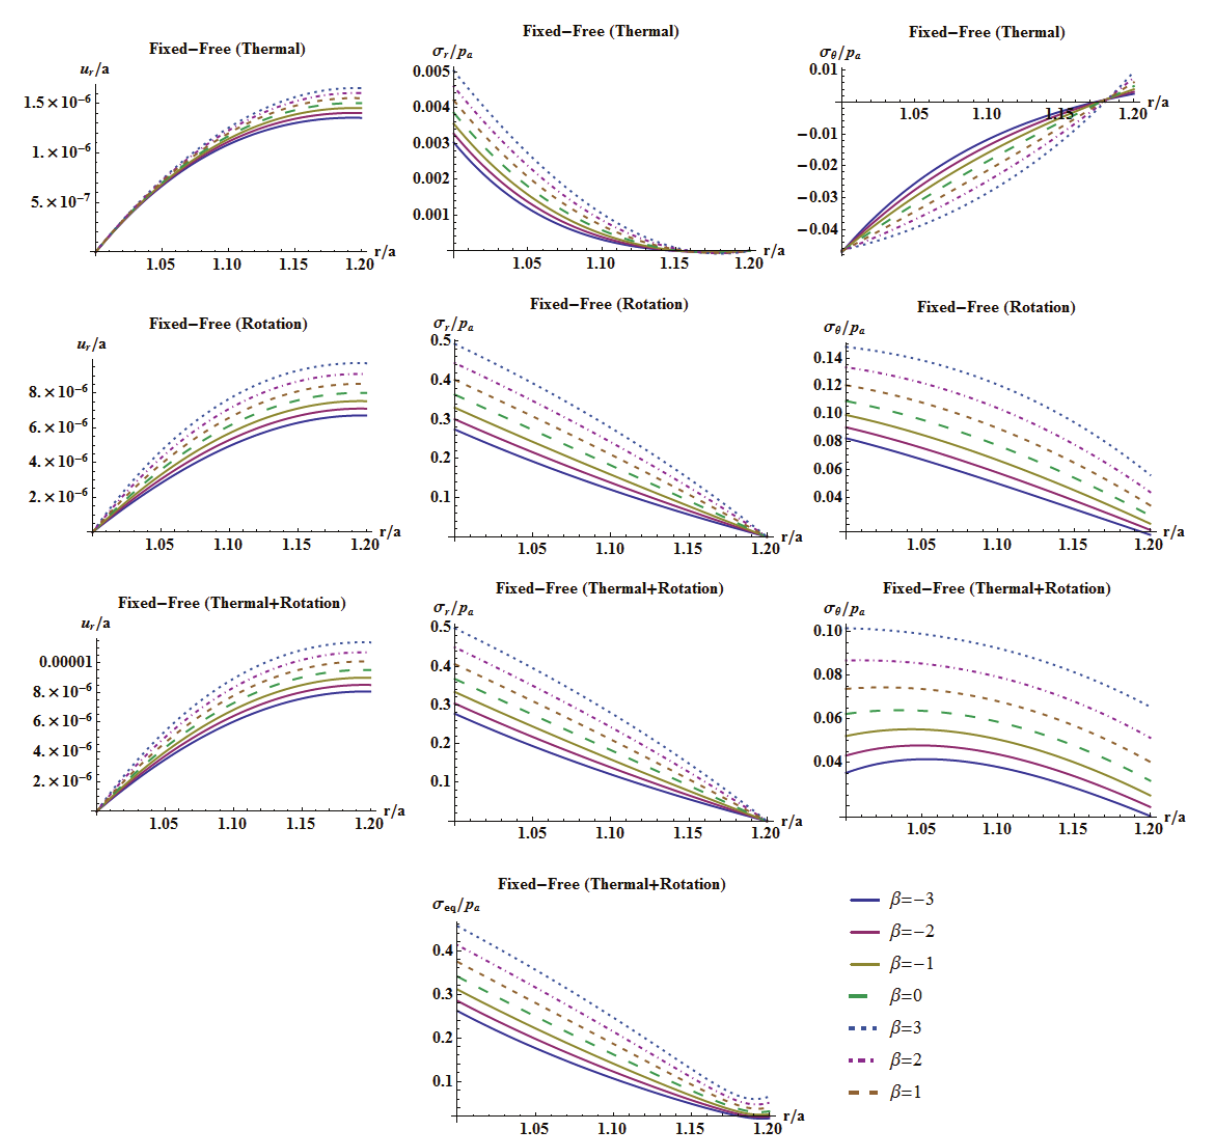
Figure 2. Variation of the dimensionless elastic fields with the inhomogeneity index under individual and combined loads for fixed-free boundary conditions.